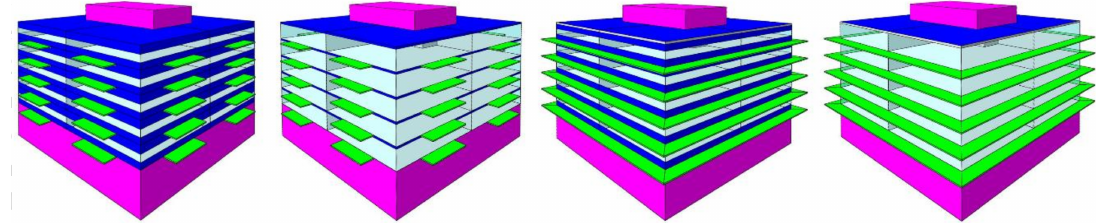
Figure 8. Five-story building models with di ff erent window to wall ratio (WWR) and balcony